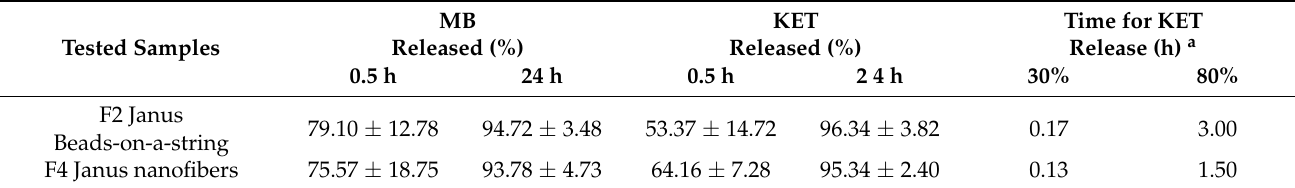
Table 2. A comparison of the drug release behaviors from F2 and F4.